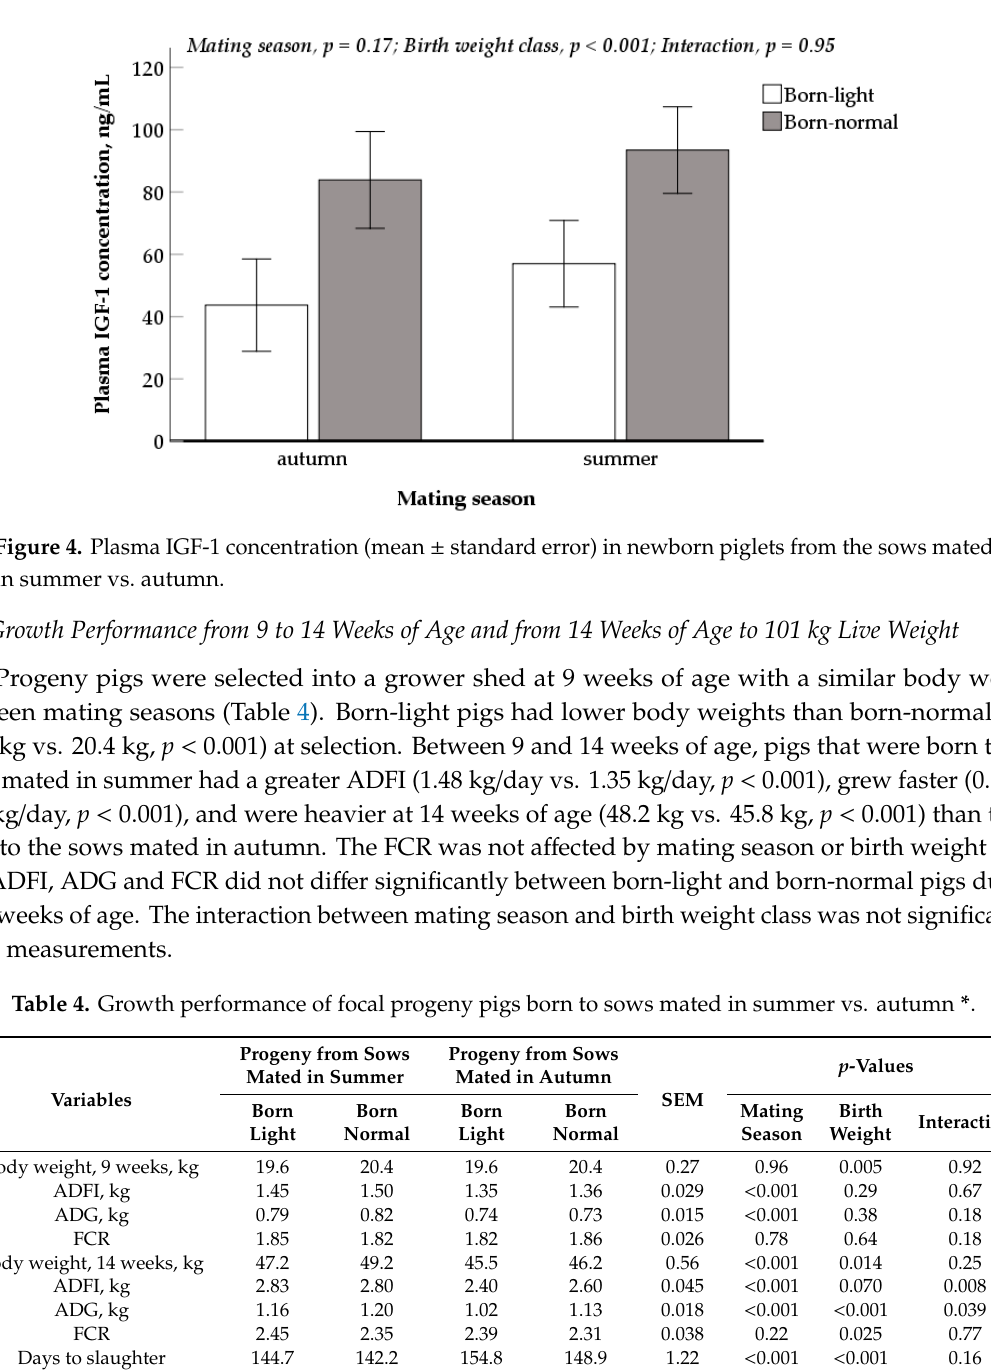
Progeny from Sows Progeny from Sows p -Values Mated in Summer Mated in Autumn SEM Born Born Born Born Mating Birth Interaction Light Normal Light Normal Season Weight